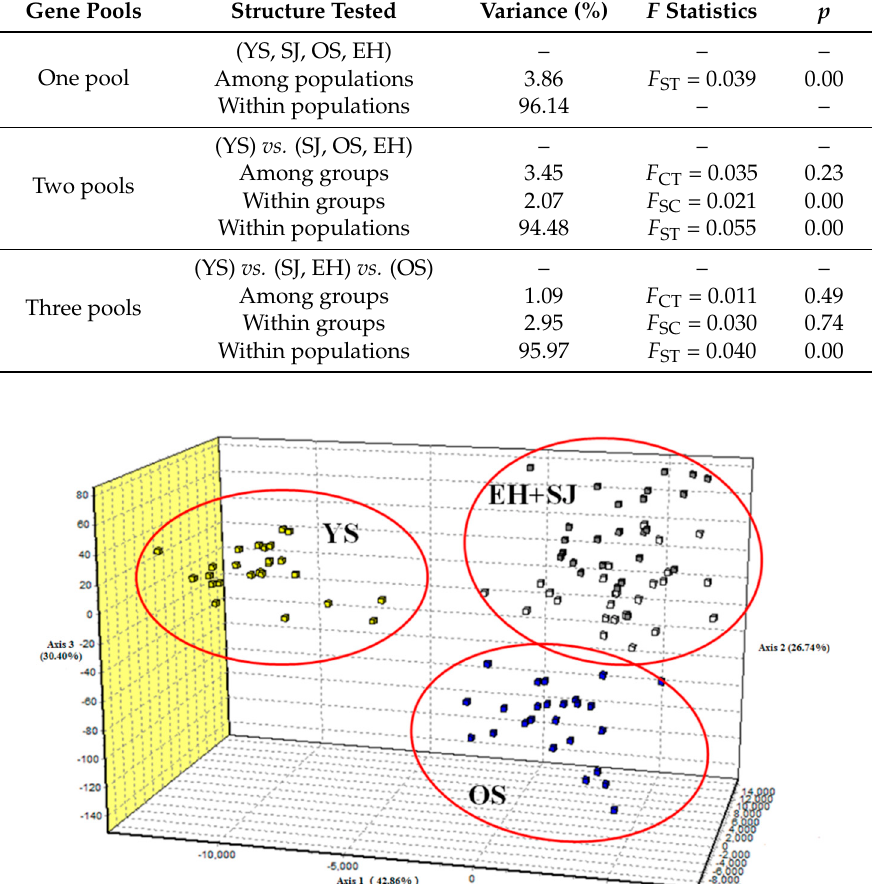
Figure 2. Three-dimensional factorial correspondence analysis (3D-FCA) showing the relationships among individuals of four populations based on eight microsatellite loci.